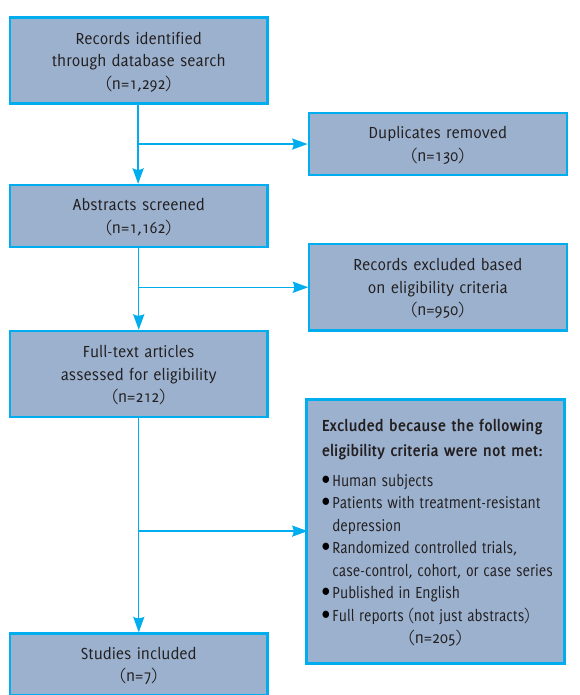
Figure 1. Flow Diagram for Article Screening and